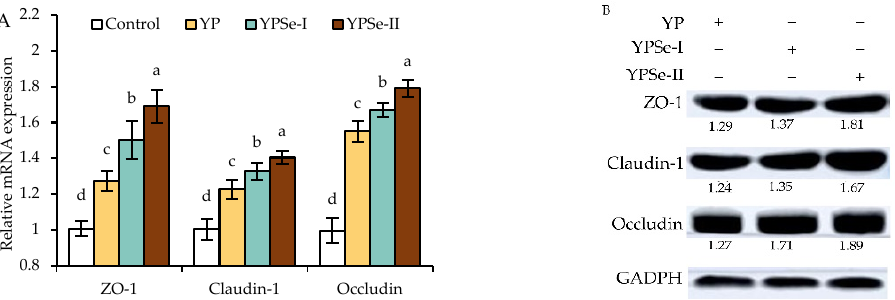
Figure 7. Relative mRNA ( A ) and protein expression levels ( B ) of three TJ proteins in IEC-6 cells incubated with YP, YPSe-I, and YPSe-II for 24 h. Different lowercase letters above the columns denote a significant difference in the one-way ANOVA means ( p < 0.05).